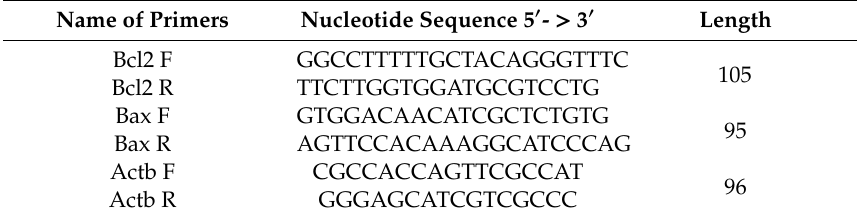
Table 3. Primers for evaluation of mRNA expression of target and reference